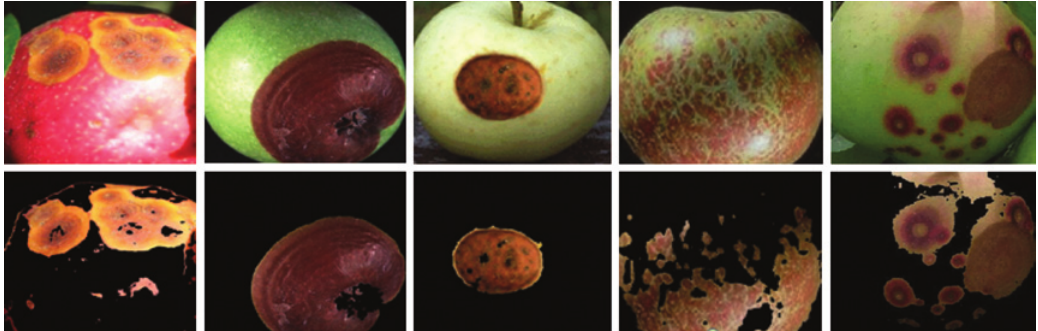
Figure 3. Some Defect Segmentation Results on the Diseased Fruit